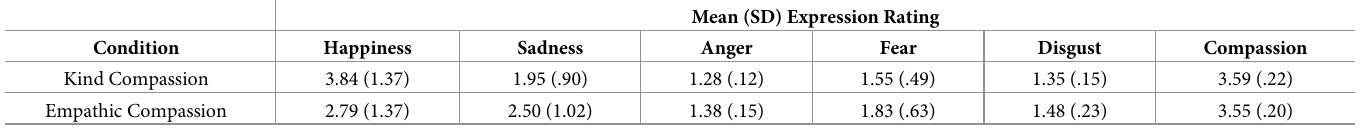
Table 1. Mean (SD) of top 10 rated faces for kind and empathic conditions.